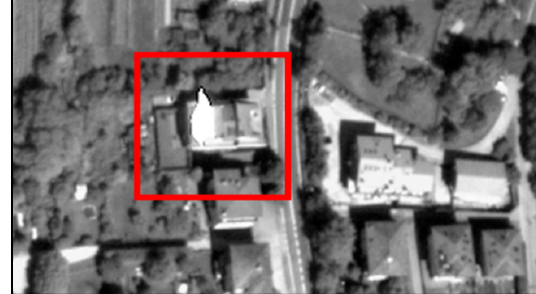
Figure 4. Examples of artefacts in WV2 images.